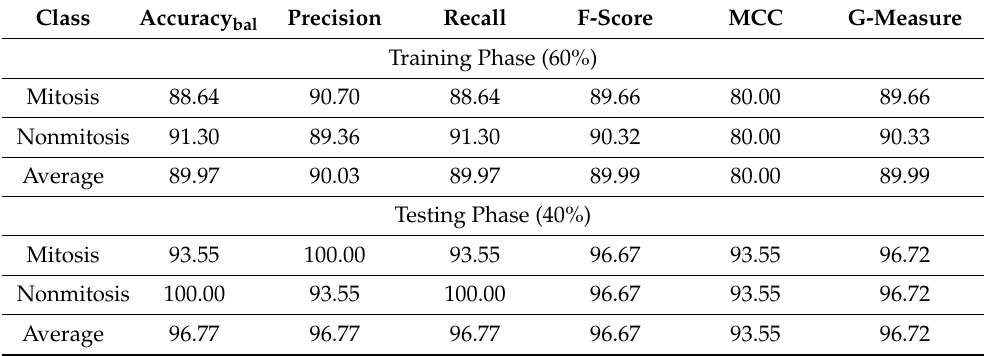
Table 2. Mitosis classification outcome of AHBATL-MNC approach under 60:40 of TR/TS